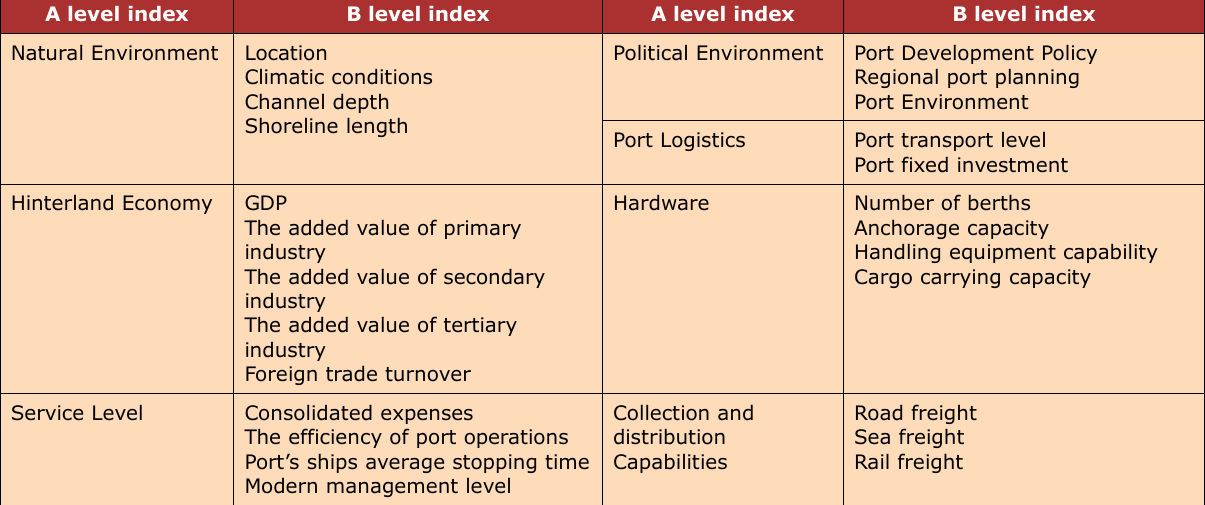
Table 1. Port Throughput Influence Index